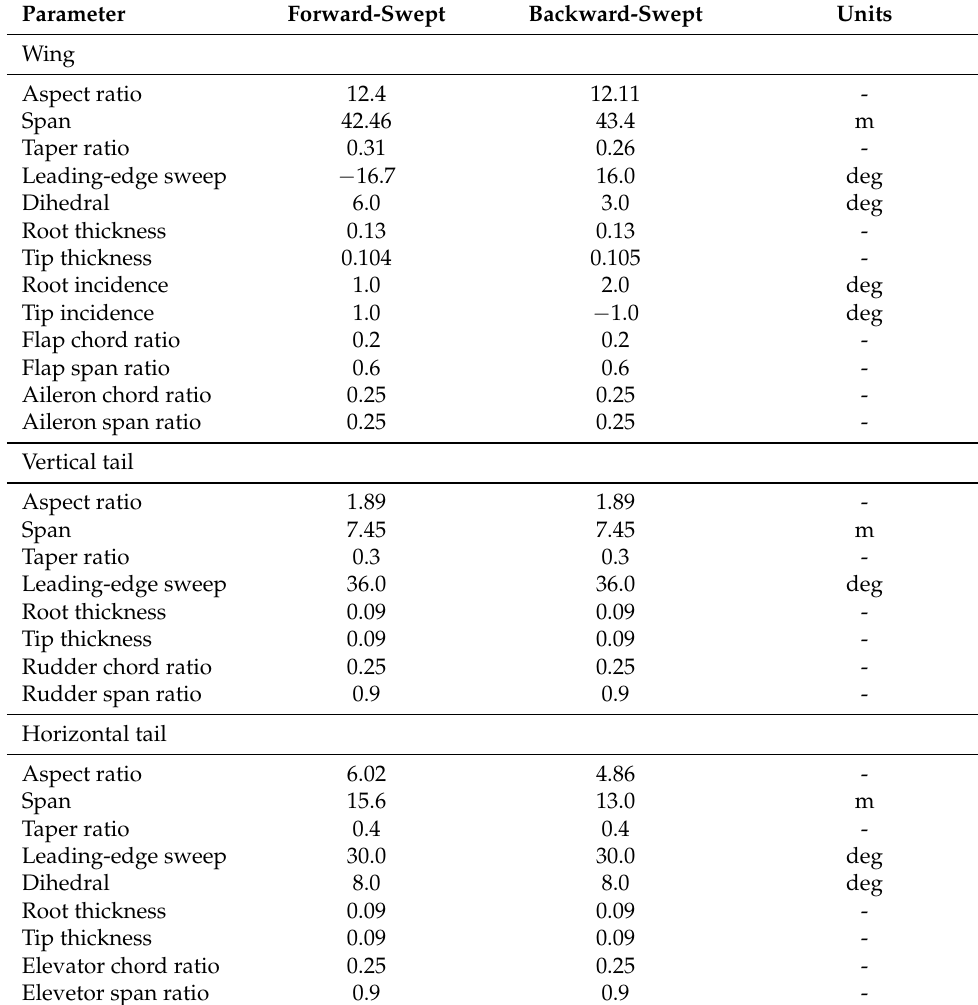
Table 7. Final design summary of two